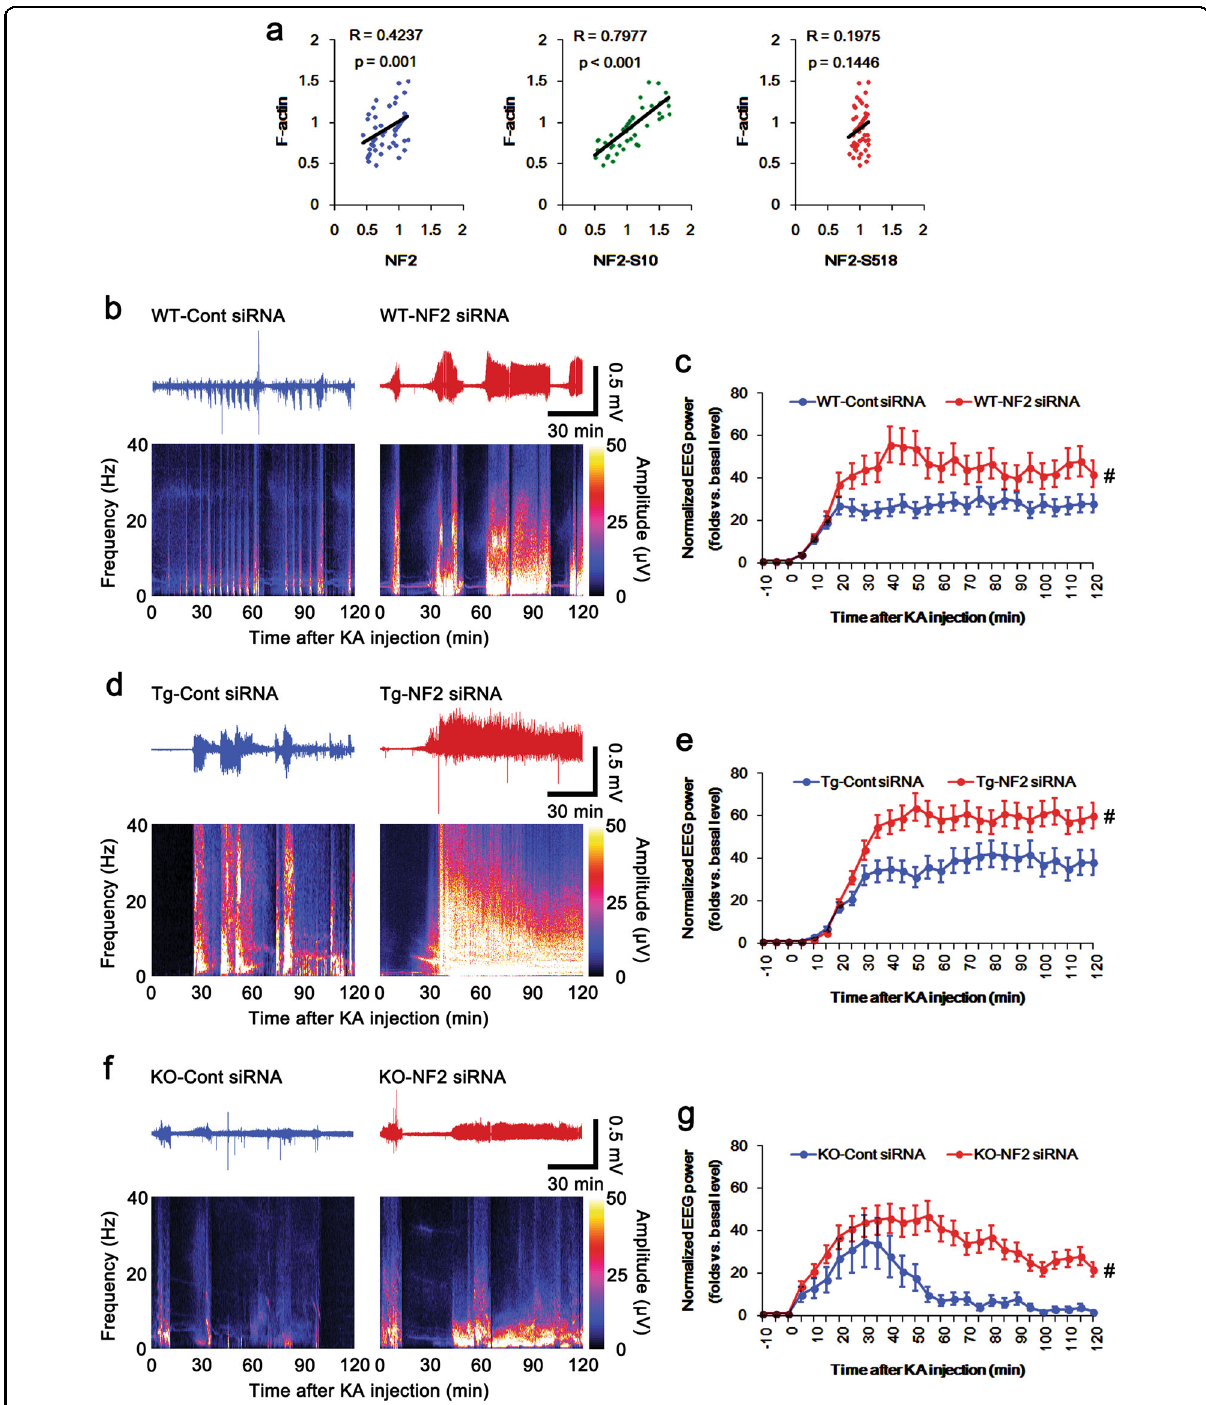
Fig. 5 Linear regression analysis between NF2 expression and F-actin contents and the effects of NF2 knockdown on seizure activity in response to KA in PLPP/CIN Tg and PLPP/CIN − / − mice. a Linear regression analysis between NF2 expression and F-actin contents within control siRNA- and NF2 siRNA-treated groups of WT, PLPP/CIN Tg and PLPP/CIN − / − mice under physiological conditions. b – g Representative EEG traces and frequency-power spectral temporal maps ( b , d , f ) and quanti fi cation of total EEG power (seizure intensity) in response to KA ( c , e , g ) in WT ( b , c ), PLPP/ CIN Tg ( d , e ) and PLPP/CIN − / − ( f , g ) mice ( # p < 0.05 vs. control siRNA-treated animals; n = 7,